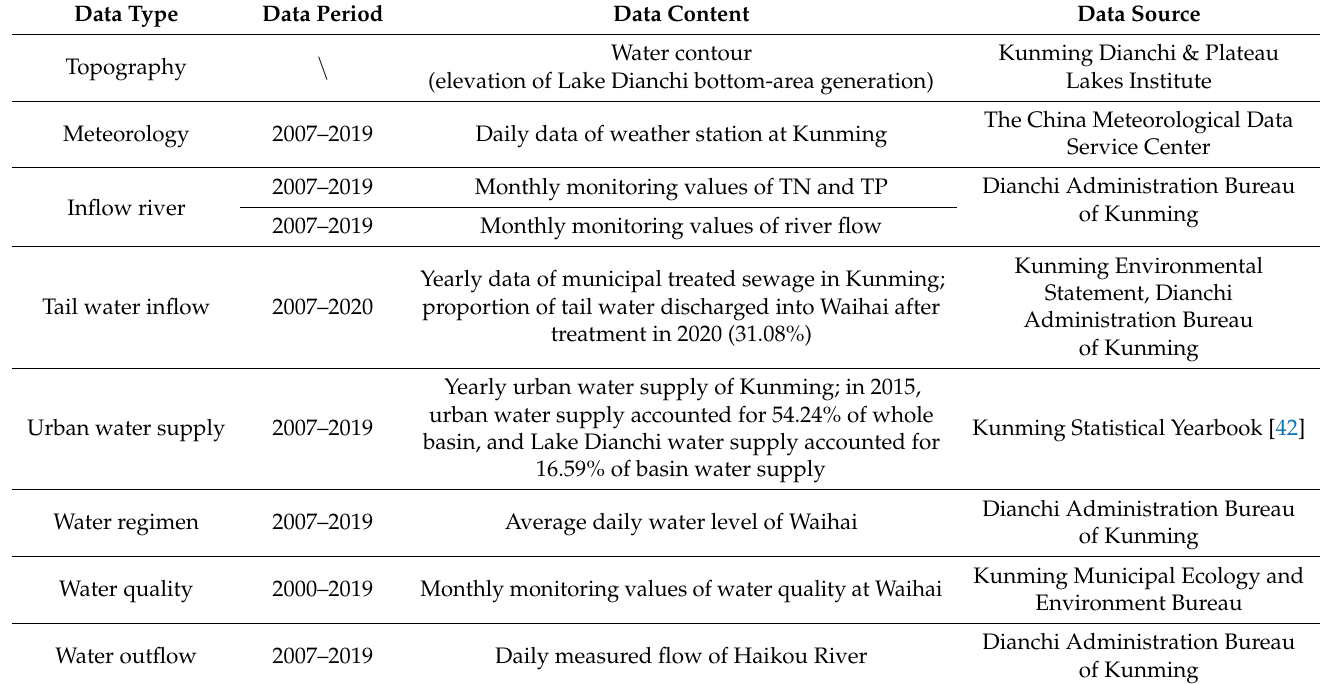
Table 1. Data information.